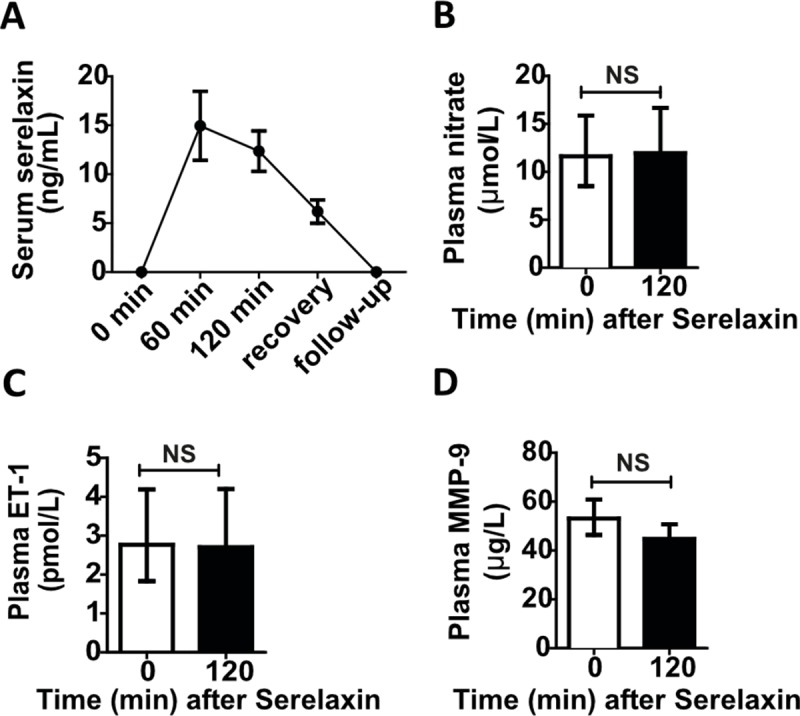
Effect of serelaxin infusion on pharmacokinetics and plasma biomarkers in patients with cirrhosis and portal hypertension.Serum serelaxin concentration measured by ELISA pre-dose (0 min), at 60 min and 120 min post-initiation of serelaxin infusion, in recovery period (~60 min after cessation of serelaxin), and at 4-wk follow-up visit (A). Data presented as mean ± standard deviation (n = 20). Plasma nitrate (B), endothelin-1 (ET-1) (C), and matrix metalloproteinase-9 (MMP-9) (D) measured by ELISA pre-dose (0 min) and at 120 min after initiation of serelaxin infusion. Data presented as geometric mean ± 95% CI (n = 20). NS, not significant.